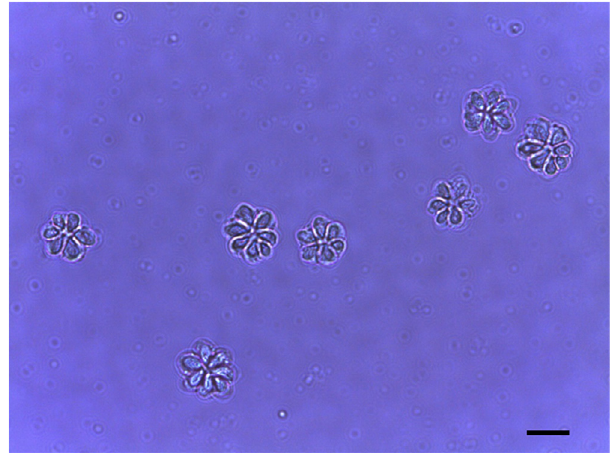
Figure 1. A histological section of olive flounder ( Paralichthys olivaceus ) muscles showing muscle fibres containing Kudoa spores. Arrows indicate spore-containing cysts. Haematoxylin and eosin- staining. Scale bar = 100 l m.